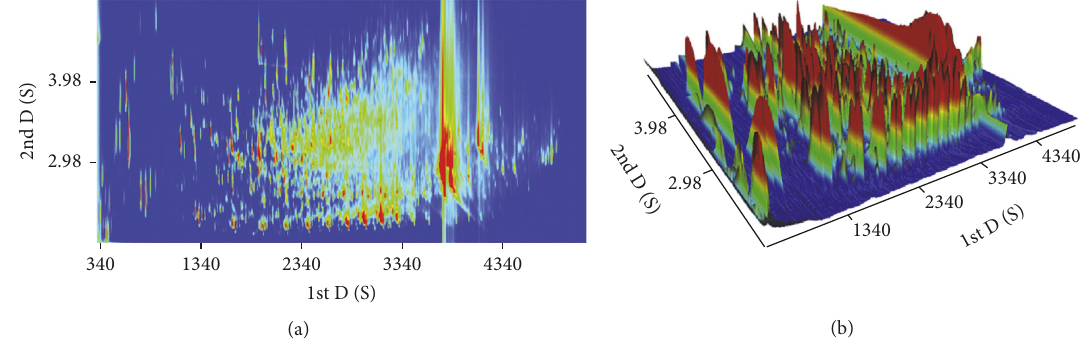
Figure 2: Typical GC × GC/TOFMS analysis of crude pyrolysis oil. (a) Topographic map and (b) tridimensional view